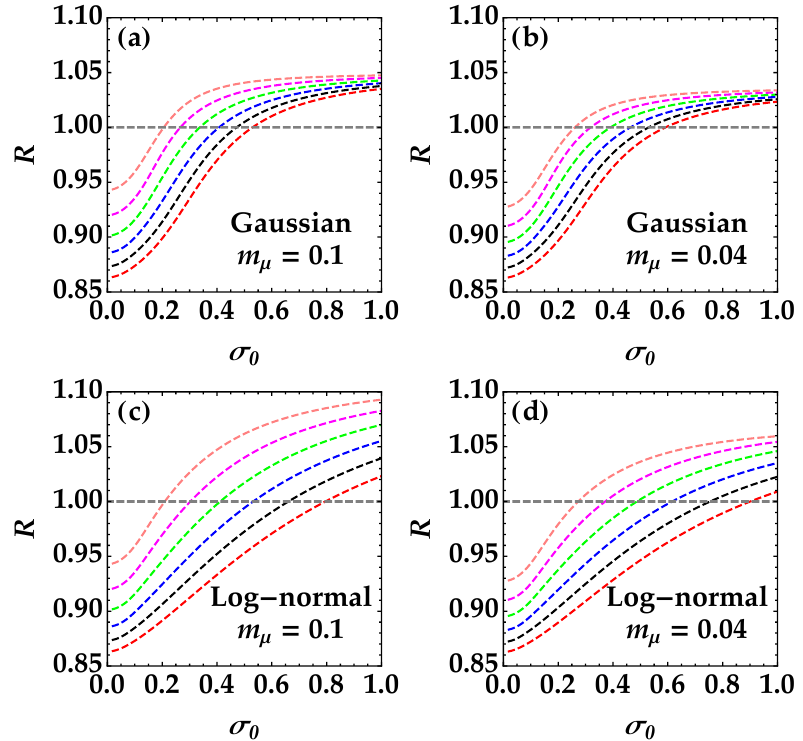
Figure 6. Theoretical values of the noise reduction factor as a function of the standard deviation σ 0 of the Gaussian (panels ( a , b )) and log-normal (panels ( c , d )) distributions for different values of t 0 . For all the shown curves we set (cid:104) m (cid:105) = 2.23, η = 0.145. In panels ( a , c ) m µ = 0.1, while in panel ( b , d ) m µ = 0.04. In each panel, the pink curve corresponds to t 0 = 0.4, the magenta curve to t 0 = 0.5, the green curve to t 0 = 0.6, the blue curve to t 0 = 0.7, the black curve to t 0 = 0.8 and the red curve to t 0 =